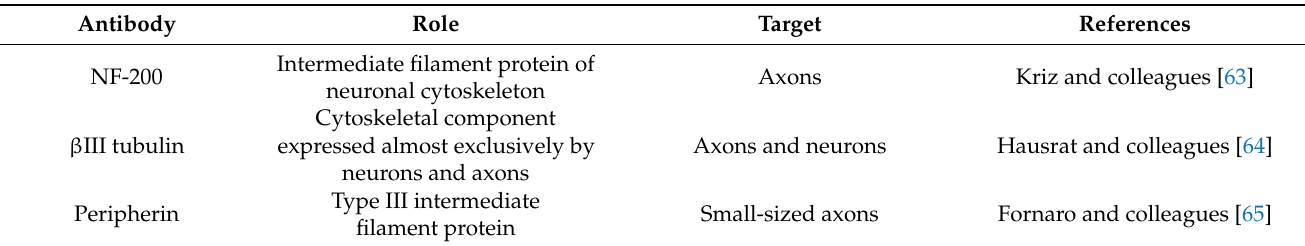
Table 2. Axonal and glial antibodies useful to study nerve